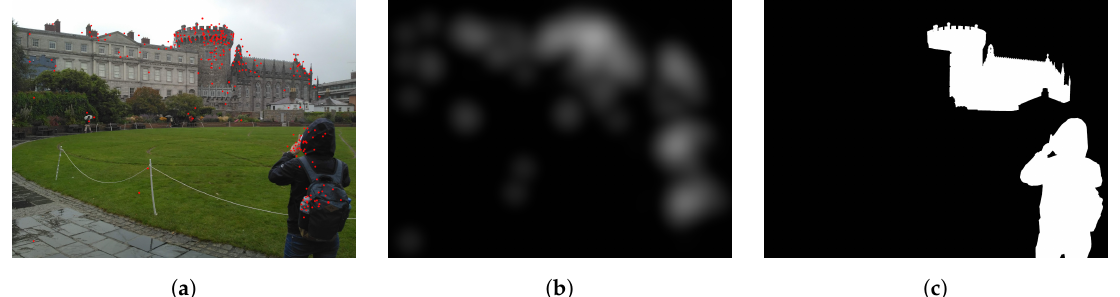
Figure 2. Different representations used for visual saliency ground truth: fixation points relative to scanpaths ( a ), continuous saliency maps directly related to fixations ( b ), and sharp salient object regions ( c